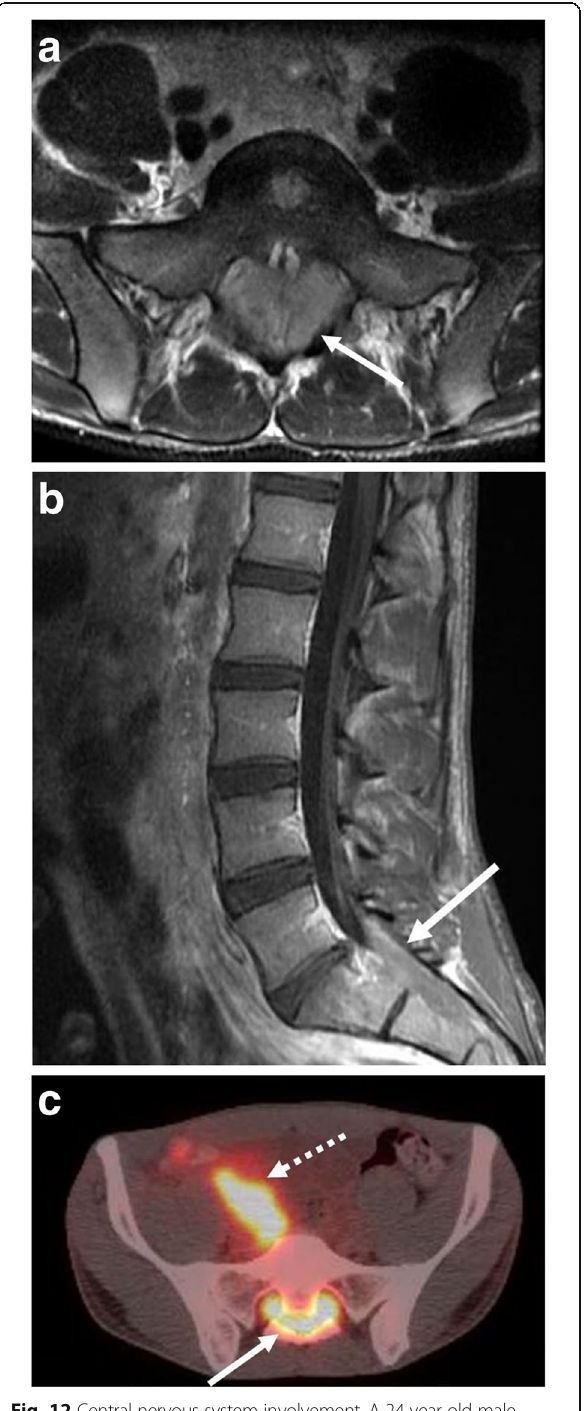
Fig. 12 Central nervous system involvement. A 24-year-old male presenting with abdominal and lower back pain. a Axial T2-weighted and ( b ) sagittal post contrast images of the lumbar spine and sacrum demonstrate an enhancing soft tissue mass within the lower spinal canal (arrows) with extension into bilateral sacral neural foramina. c Fused axial PET-CT demonstrates associated hypermetabolic activity within the sacral mass (solid arrow). Involvement of the right retroperitoneum is also seen (dashed